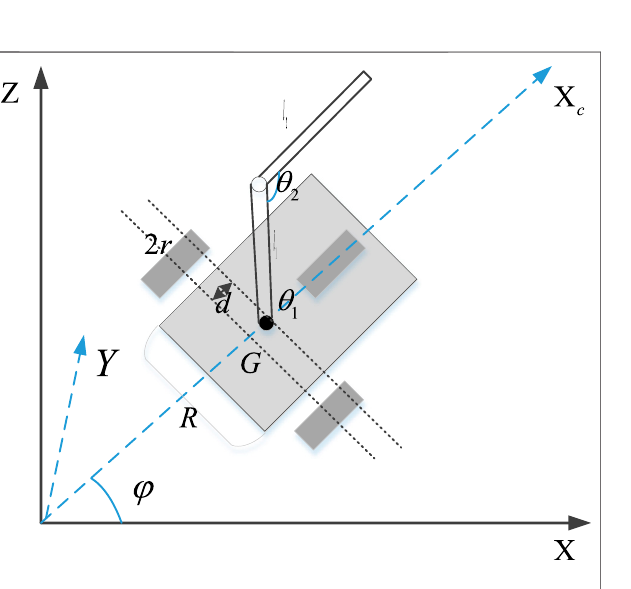
FIGURE 4 | The model diagram of a two-link bio-inspired mobile